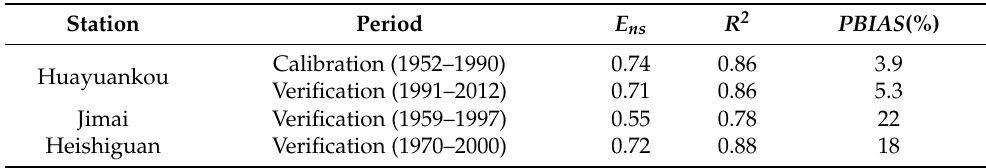
Table 3. Evaluation of HBV-D performance for monthly simulation through three hydrological stations in the Yellow River